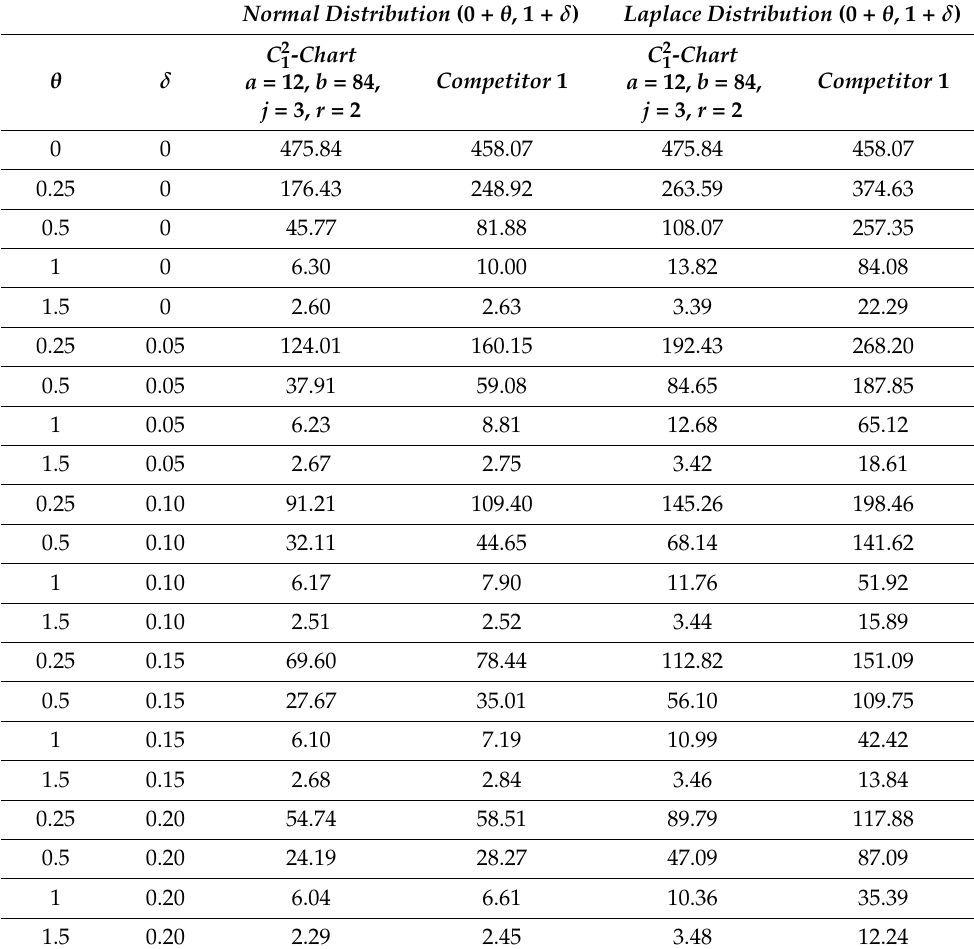
− control charts against competitive schemes under different process Table 5. ARL values of the C 2 1 distributions and several shifts θ , δ ( m = 100, n =